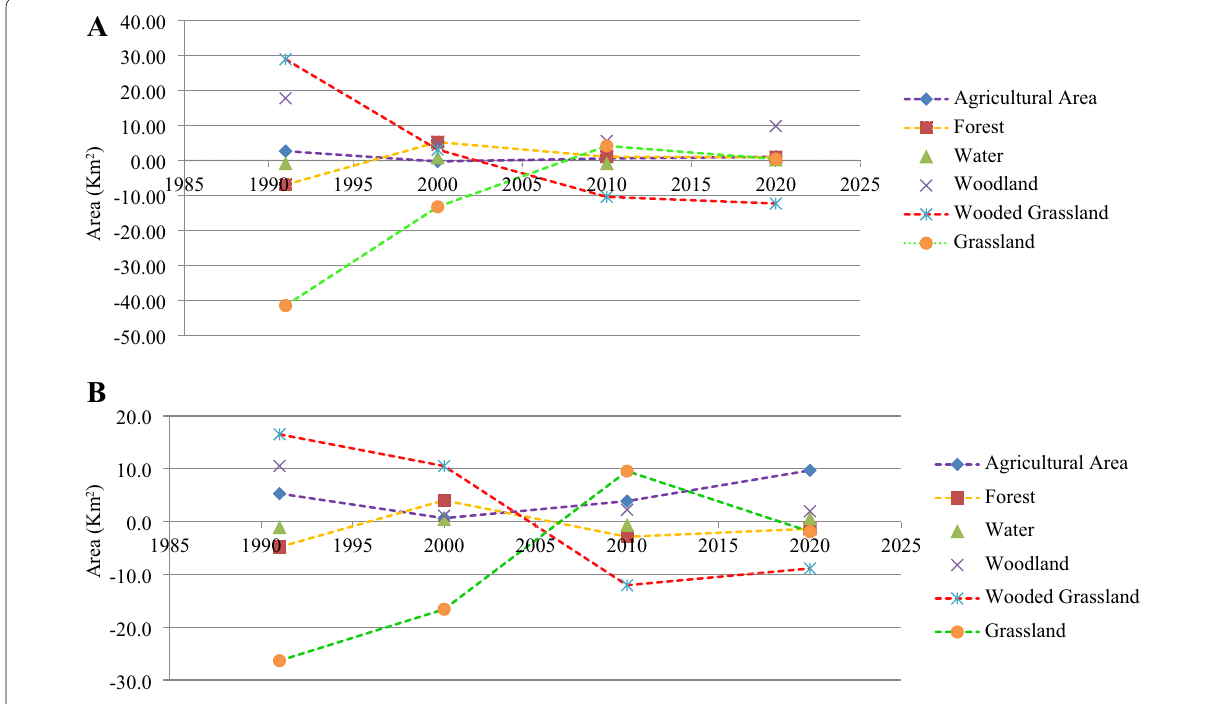
Fig. 4 The trends of annual change rate of LULC within the park and buffer